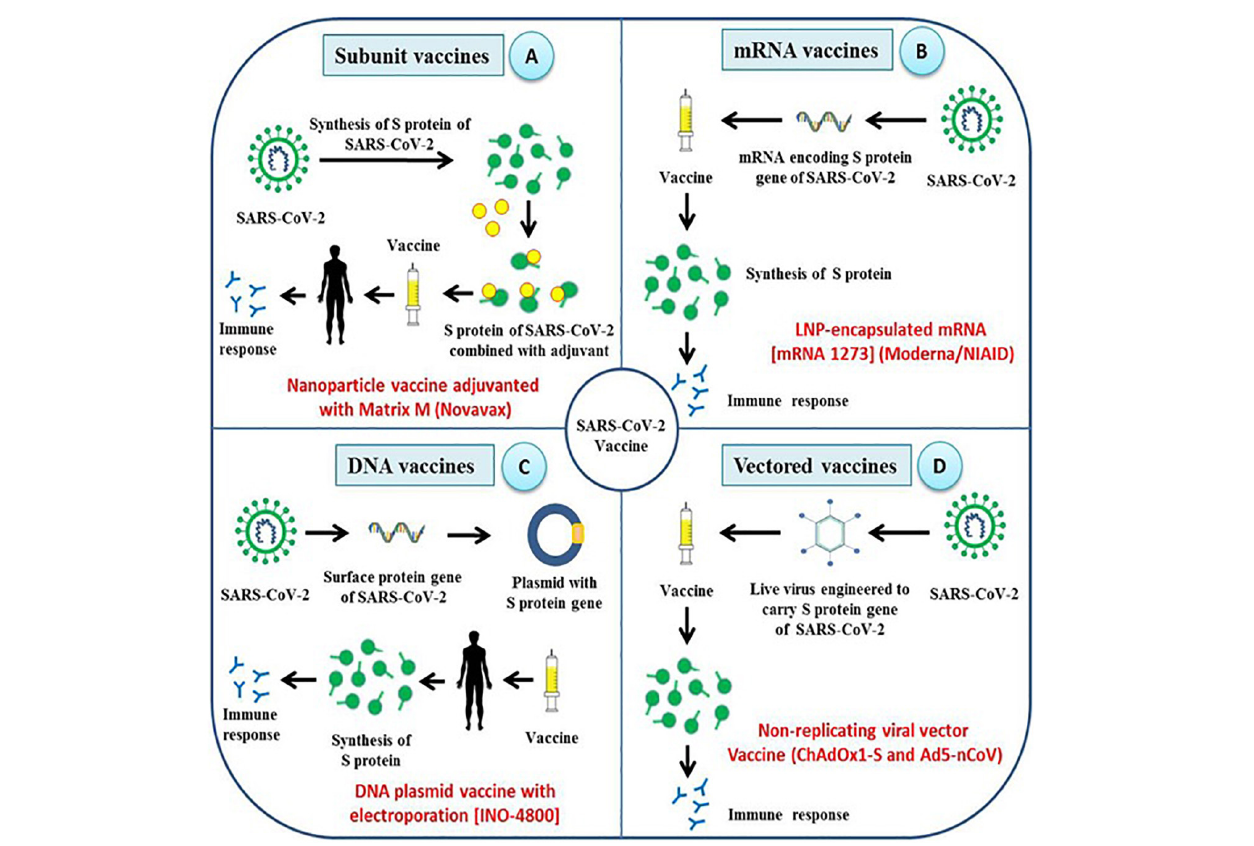
FIGURE 3 | Different strategies employed for the development of vaccines against SARS-CoV-2. Research institutions along with pharmaceutical companies across the world are adopting unique strategies to develop effective vaccines against SARS-CoV-2 and most of them target spike proteins and its functional domains. (A–D) The type of vaccine being developed includes subunit vaccine, mRNA vaccine, DNA vaccine and viral-vector based vaccines which aim to elicit humoral as well as cellular immune response against spike protein of